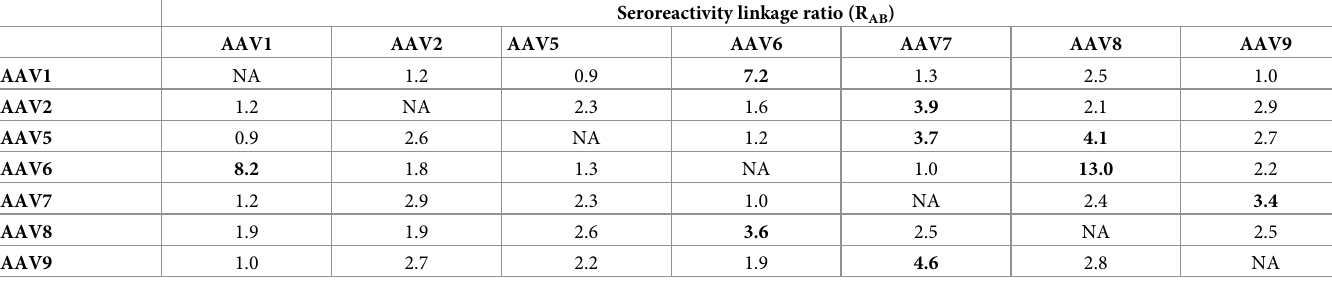
Table 2. Linkage of seroreactivity (R AB ) between AAV serotypes in client-owned cats in Switzerland (NAb titer: